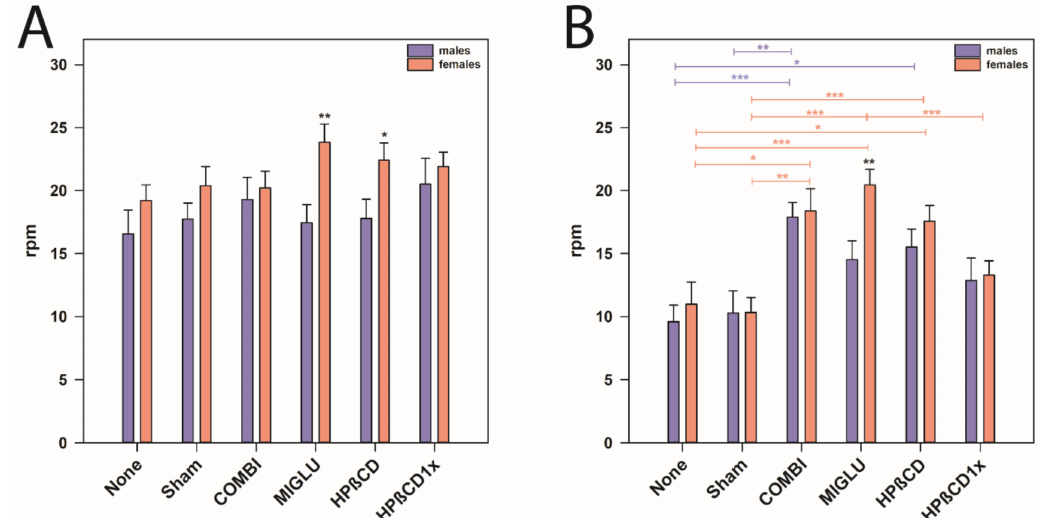
Figure 6. Accelerod test ( A , B ) revealed an obvious motoric phenotype of NPC1 − / − mice that was improved by all treatment options. However, we detected gender-specific differences of MIGLU treatment between the genotype groups. ( A ) NPC1 +/+ mice, ( B ) NPC1 − / − mice. Significant post hoc tests are indicated by asterisks (* p < 0.05, ** p < 0.01, *** p < 0.001). Data are means ± SEM.